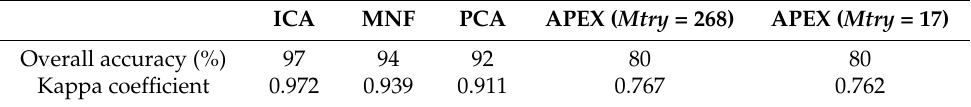
Table 2. Classification accuracy assessment according to overall accuracy and kappa coefficient.